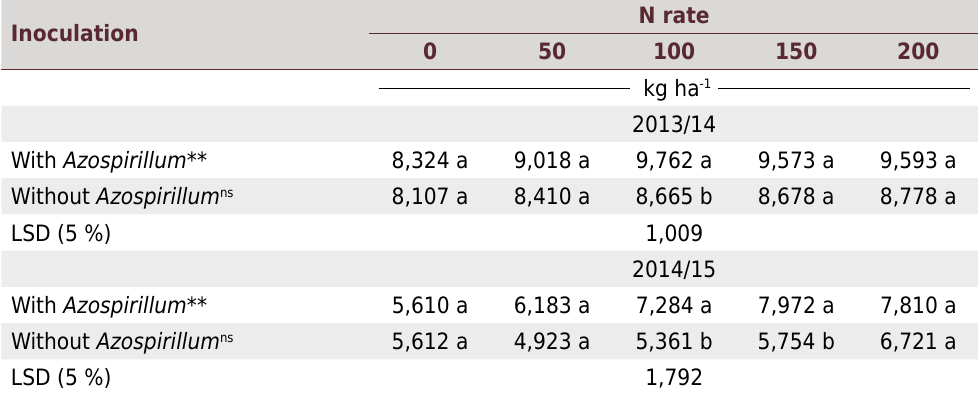
Table 5. Inoculation and nitrogen rate interaction for corn grain yield (2013/14 and